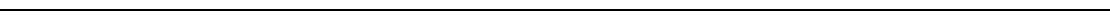
Fig. 3 DUX4 induces skeletal muscle atrophy. a Mass of various muscles normalized to the body weight ( BW ) of iDUX4pA male mice treated with doxycycline over doses and time ranges ( n = 3). b Speci fi c isometric, concentric and eccentric forces and 1/2 relaxation time (1/2 TPT) of EDL in 10-week-old iDUX4pA male mice induced with 5 mg/kg doxycycline for 28 days ( n = 4). c Immunostaining for DUX4 and laminin on quadriceps of iDUX4pA;HSA-rtTA males induced with 5 and 100 mg/kg doxycycline for 14 days. DAPI was used for nuclear staining. d RTqPCR analyses for DUX4 and DUX4 target genes Myo1g , Wfdc3 , Azi2 , Cdkn1a , and Zscan4c in pectoralis muscle and liver of iDUX4pA;HSA-rtTA male mice induced with 25 mg/kg doxycycline for 14 days. Results are presented as fold difference to GAPDH ( n = 3). e Hematoxylin and Eosin ( H&E ) staining and Sirius red/fast green staining of quadriceps from iDUX4pA;HSA-rtTA male mice induced with 5 and 100 mg/kg doxycycline for 14 days ( left ). Quanti fi cation of fi brous tissue in control and induced (100 mg/kg) quadriceps ( n = 3, right ). f RTqPCR for indicated fi brogenic markers in iDUX4pA;HSA-rtTA males mice induced with 5 mg/kg doxycycline for 14 days. Results presented as fold difference to GAPDH ( n = 3). g Representative FACS analyses for hematopoietic in fl ammatory cells expressing CD45 and CD68, CD206 or Ly6G in muscle of iDUX4pA;HAS-rtTA males or control siblings (WT or lacking rtTA) induced with 25 mg/kg doxycycline for 14 days ( left ), and summary data ( right , n = 4). Data are presented as mean ± SEM; * p < 0.05, ** p < 0.01, *** p < 0.001, **** p < 0.0001